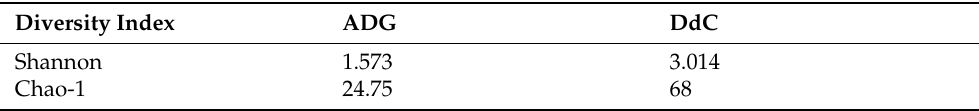
Table 3. Average values of the Alpha diversity indices at order level in digestate and digestate derived-compost.